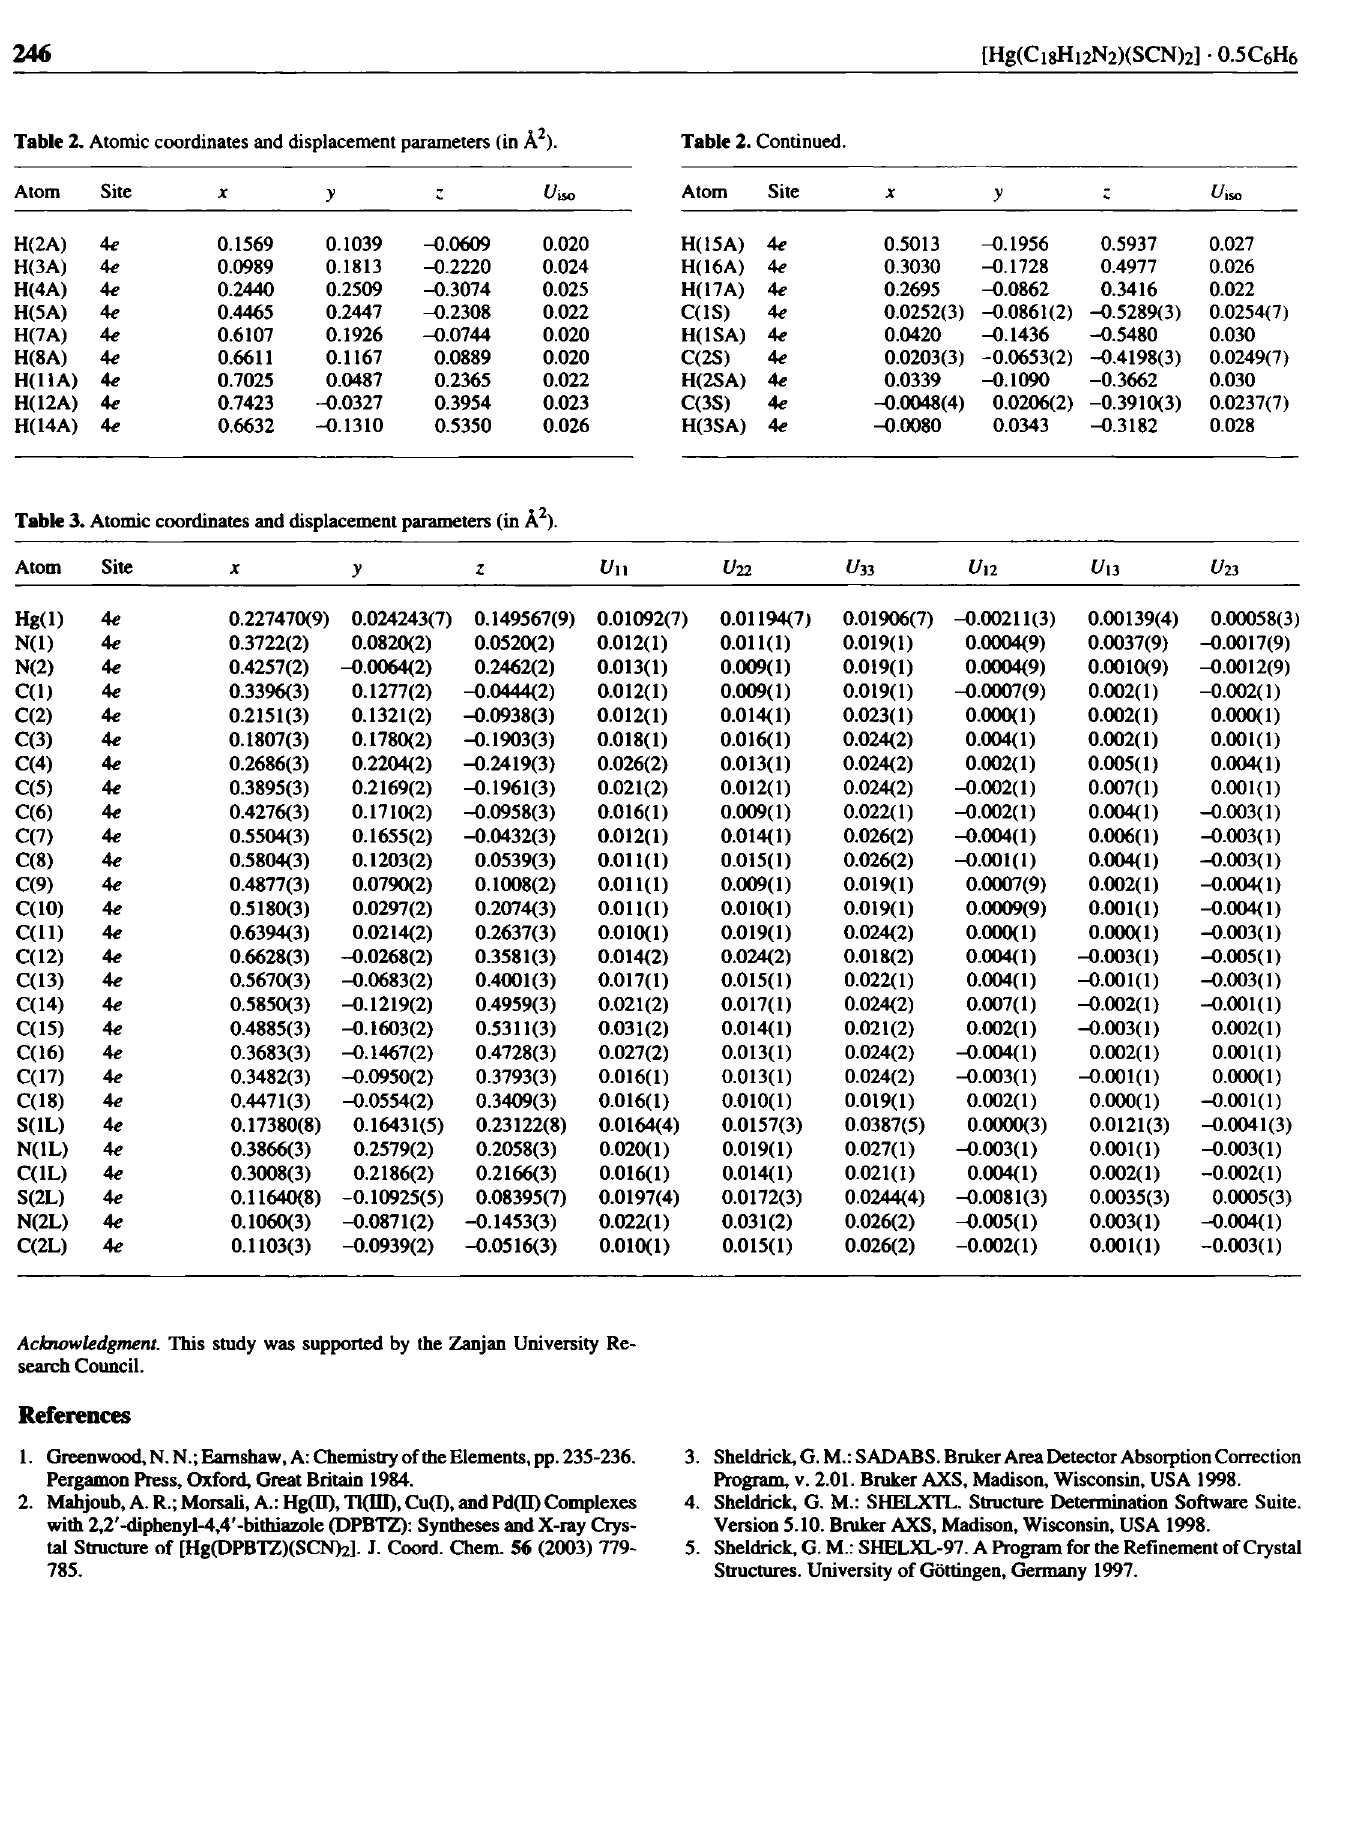
Table 2. Atomic coordinates and displacement parameters (in Â 2 ). Table 2. Continued.